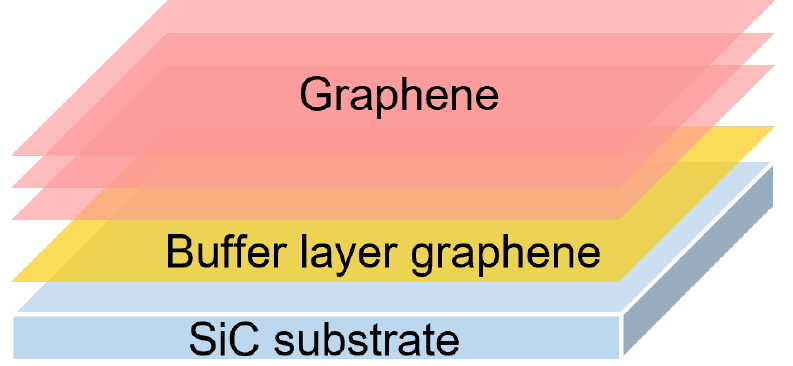
Figure 2. The schematic representation of the structure of the few-layered graphene sample. In between the few-layered graphene and the SiC substrate, there is the so-called “buffer layer” which is covalently bonded to SiC and has weak force to the top graphene layer by the vdWs force.